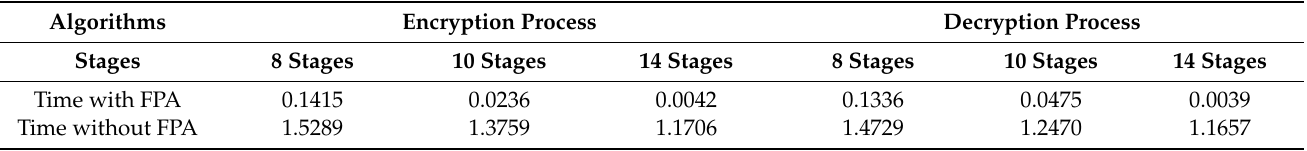
Table 3. Time Table 3. Time Efficiency.